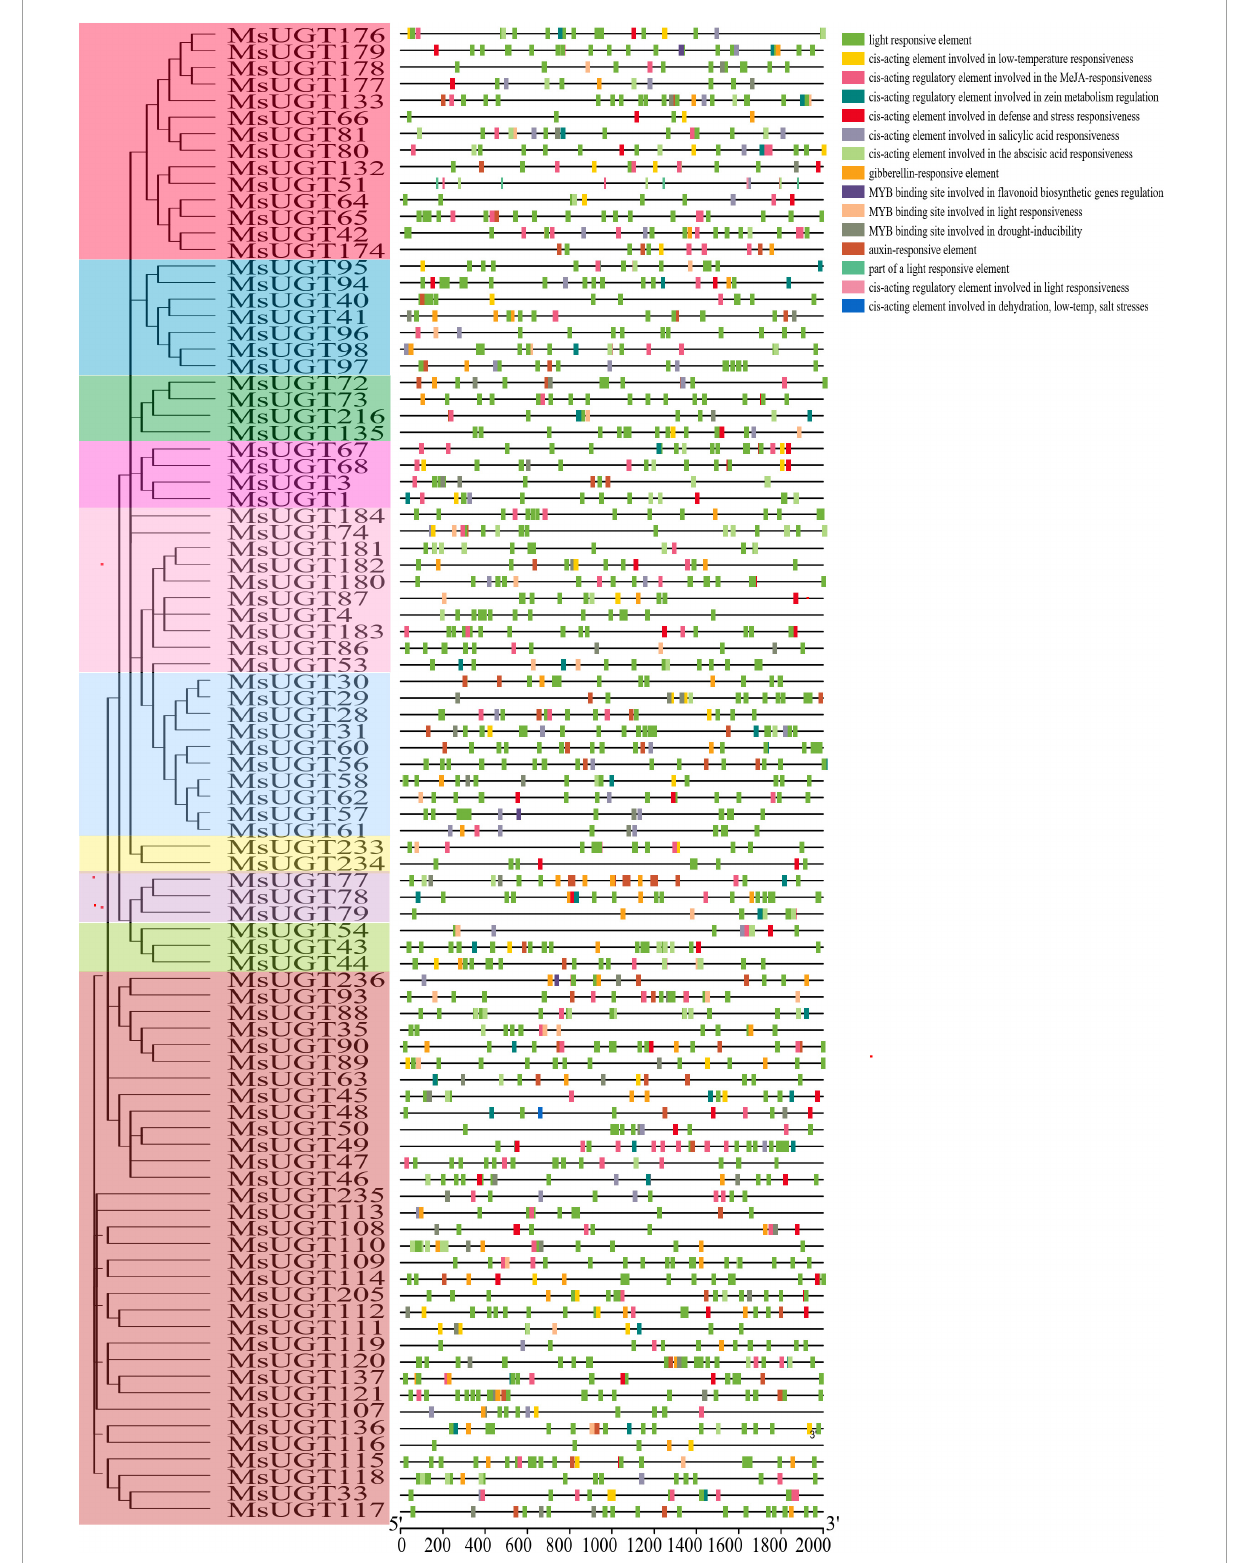
FIGURE5 Cis -acting elements analysis in the promoter region of UGT genes associated with secondary metabolism in alfalfa. Each phylogenetic group is indicated by the same color used in the evolutionary tree in Figure 2A .